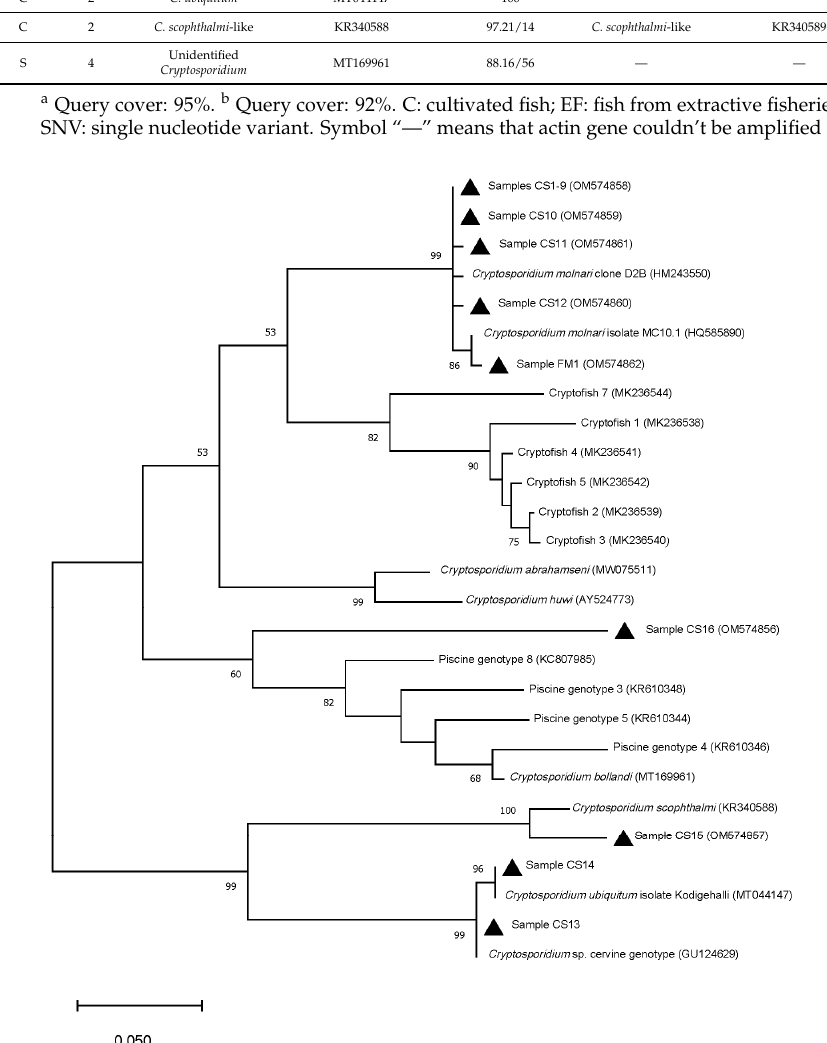
Figure 2. Phylogenetic relationships between Cryptosporidium isolates from this study ( ▲ ) and other Cryptosporidium species and genotypes inferred by Maximum-Likelihood (ML) method of 18S rRNA gene sequences (277 bp). Percentage support (>50%) from 1000 replicates (bootstrap test) is indicated at the left of the supported node. Scale bar refers to a phylogenetic distance of 0.05 nucleotide substitutions per site.